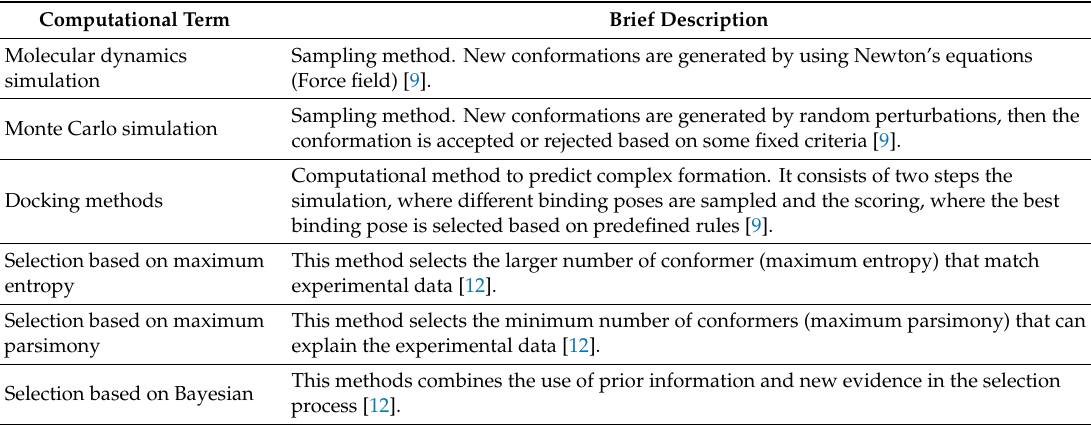
Table 1. Glossary of some computational